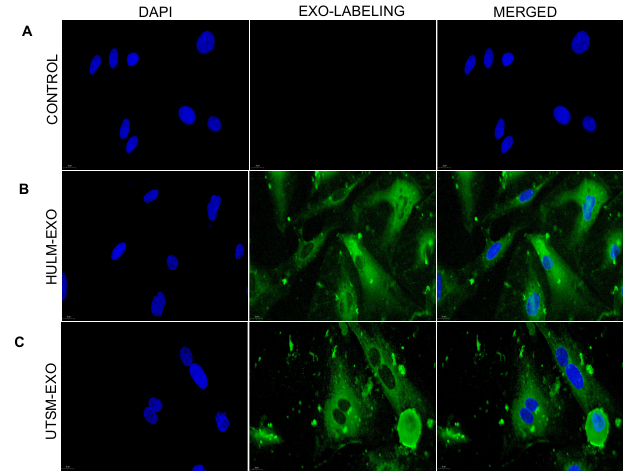
Figure 2. Uptake of exosomes derived from human uterine leiomyoma by human endometrial microvascular endothelial cells. ( A – C ) representative confocal microscopy images of labeled exosomes derived from human uterine leiomyoma (HULM-EXO) and human uterine smooth muscle (UTSM-EXO) cell lines and PBS-treated as negative control, cocultured with human endometrial microvascular endothelial cells (HEMEC) at 24 h (scale bar = 200 nm). We observed a high quantity of labeled exosomes in the cytoplasm of endothelial cells, and no exosomes were detected in endothelial cells treated with PBS, confirming the effective uptake of both HULM-EXO and UTSM-EXO on HEMEC cells.